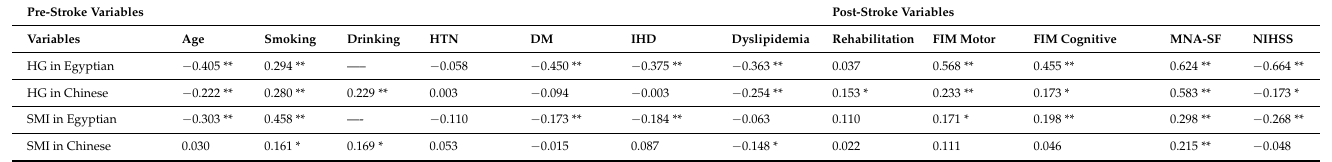
Table 3. Table 3. The Spearman correlation between pre- and post-stroke contributing variables that increase or decrease HGS and SMI among Egyptian and Chinese